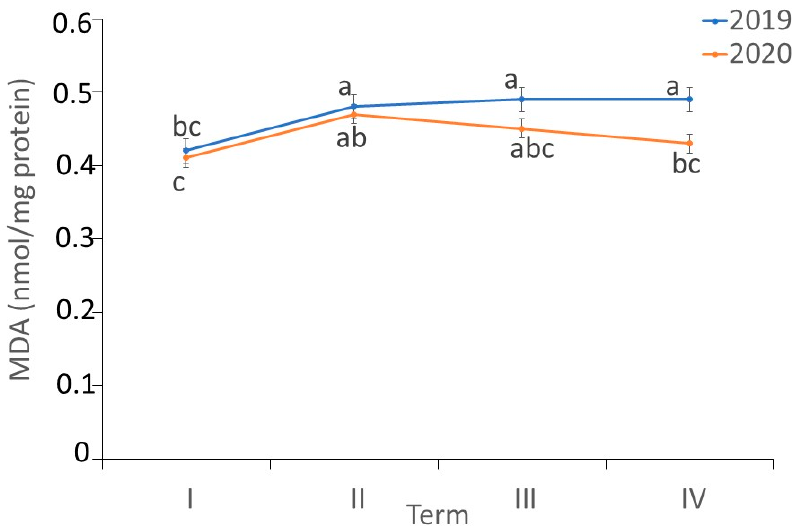
Figure 6. Changes in the malondialdehyde (MDA) content (nmol/mg protein) in A. fabae fundatrigeniae during feeding on V. opulus (means ± SD; n = 4). Different letters denote significant differences (one–way ANOVA; Tukey’s test; p < 0.05).